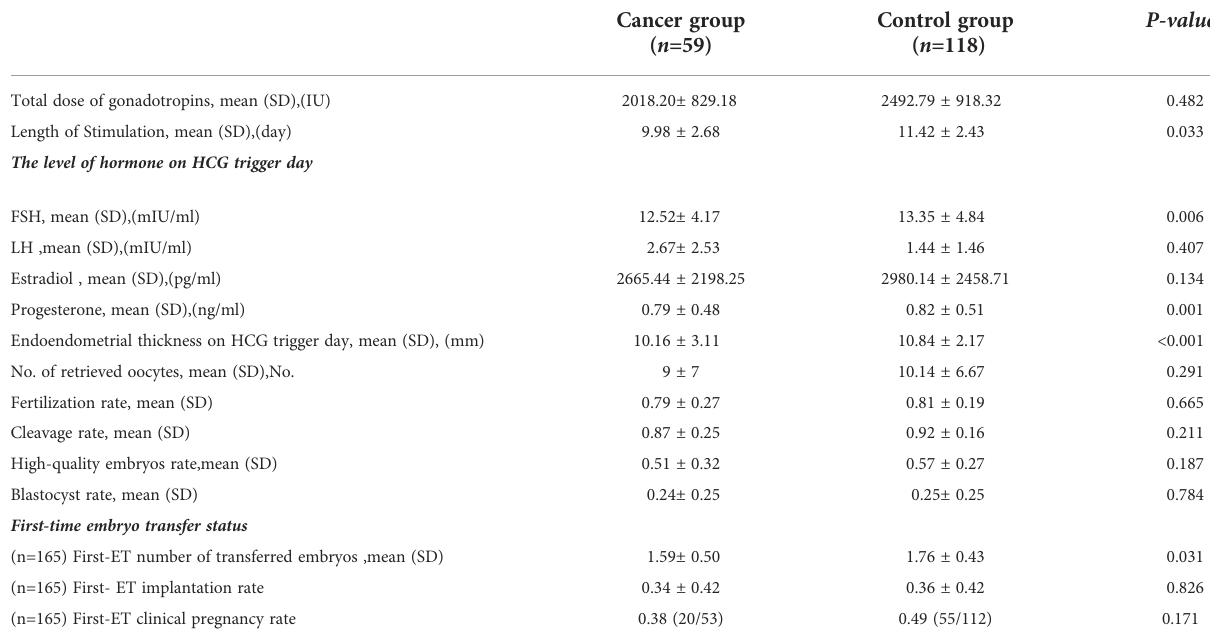
TABLE 2 The fi rst IVF /ICSI cycle